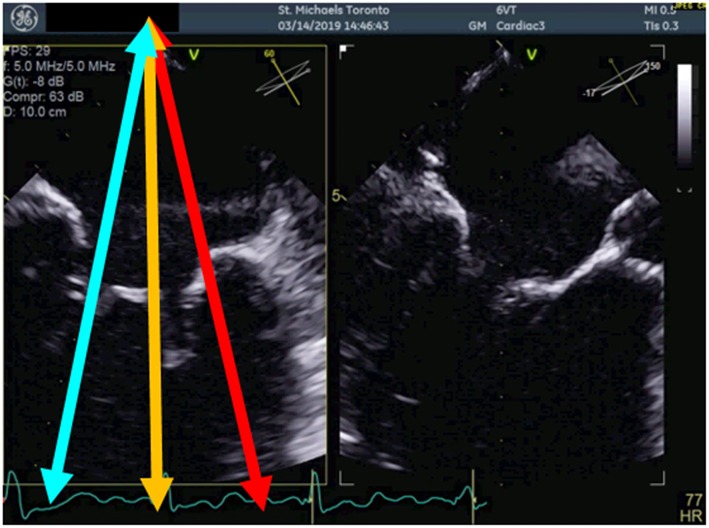
Multiplane view of the mitral valve. Mid-esophageal biplane views (left panel: 60 degree view, right panel: 150 degree view) of the mitral valve leaflets. The blue arrow demonstrates the medial aspect of the mitral valve, the orange arrow, the central aspect and the red arrow, the lateral aspect of the mitral valve.